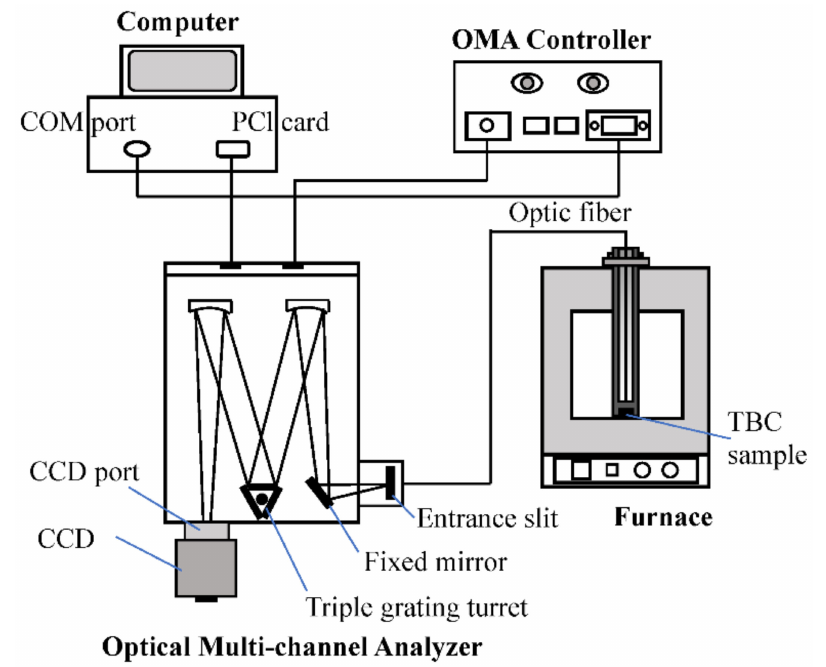
Figure 15. Schematic diagram of the system for emissivity measurement based on a high-temperature furnace [73].